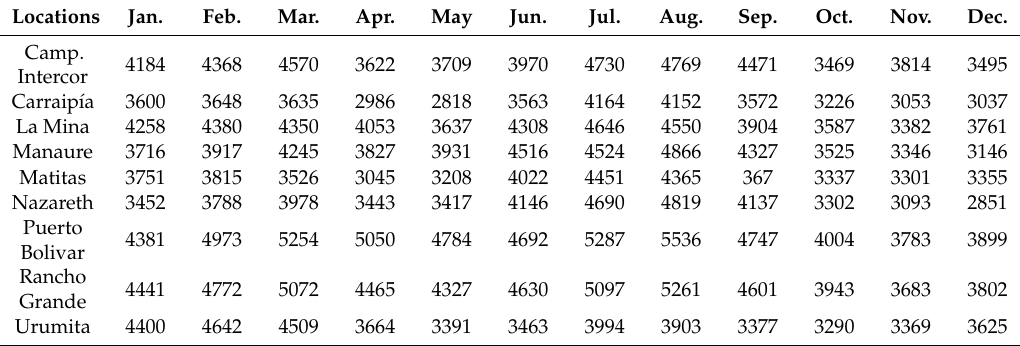
Table 2. Solar radiation [Wh / m 2 day] matrix for the di ff erent measurement points in La Guajira [17].